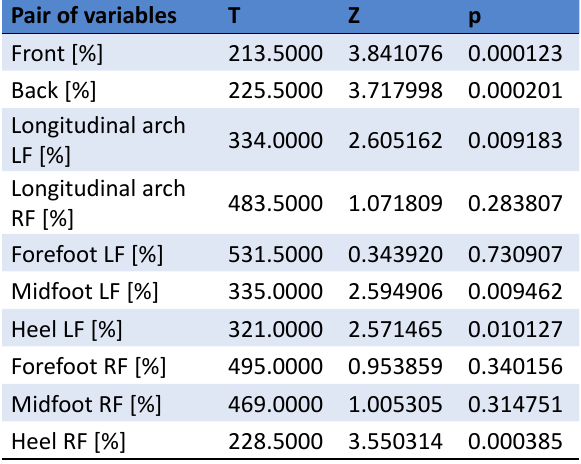
Table 9. Significance of the differences between the